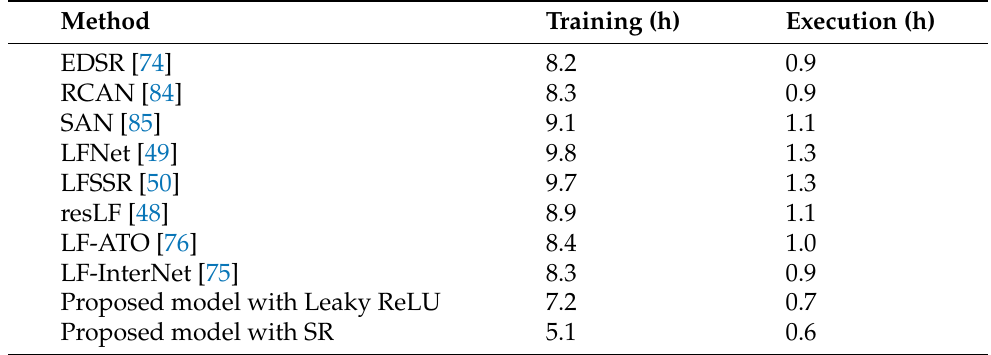
Table 5. Simulation times achieved by different methods and the proposed one for training and to execute in the LF datasets, such as INRIA [80], HCInew [81], EPFL [82], and HCIold